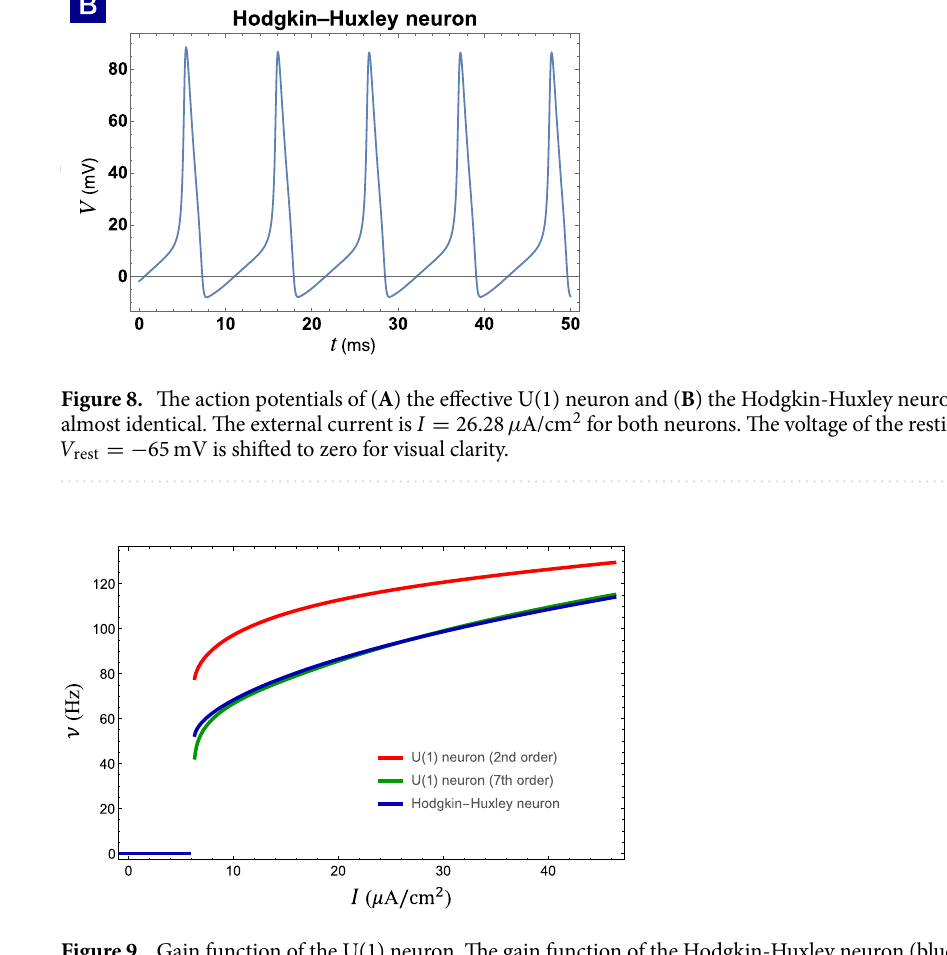
Figure 9. Gain function of the U(1) neuron. The gain function of the Hodgkin-Huxley neuron (blue) is well captured by that of the U(1) neuron with Fourier expansion to the seventh order in phase dynamics. However, the U(1) neuron to the second order delivers an approximate gain function with the same trend, indicating lower-order terms already secure the qualitative behavior of the neuronal